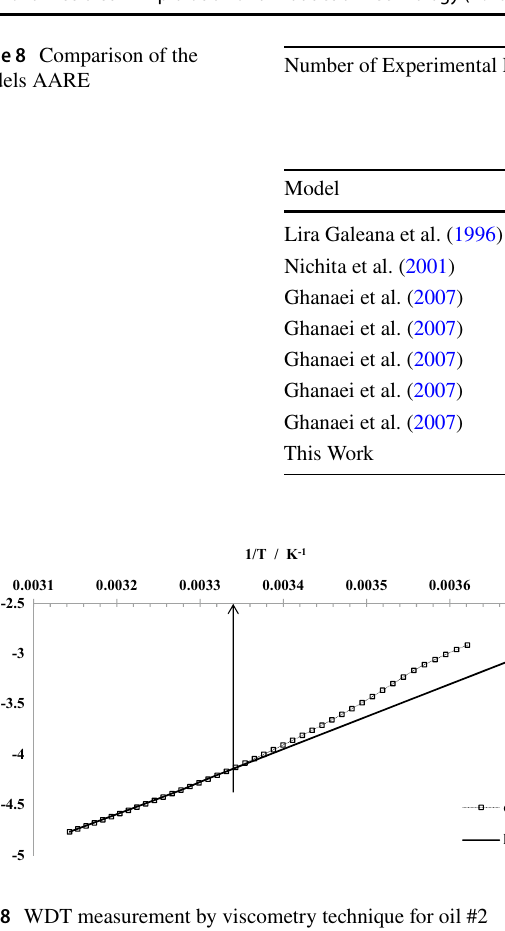
Fig. 9 WDT measurement by DSC technique for oil